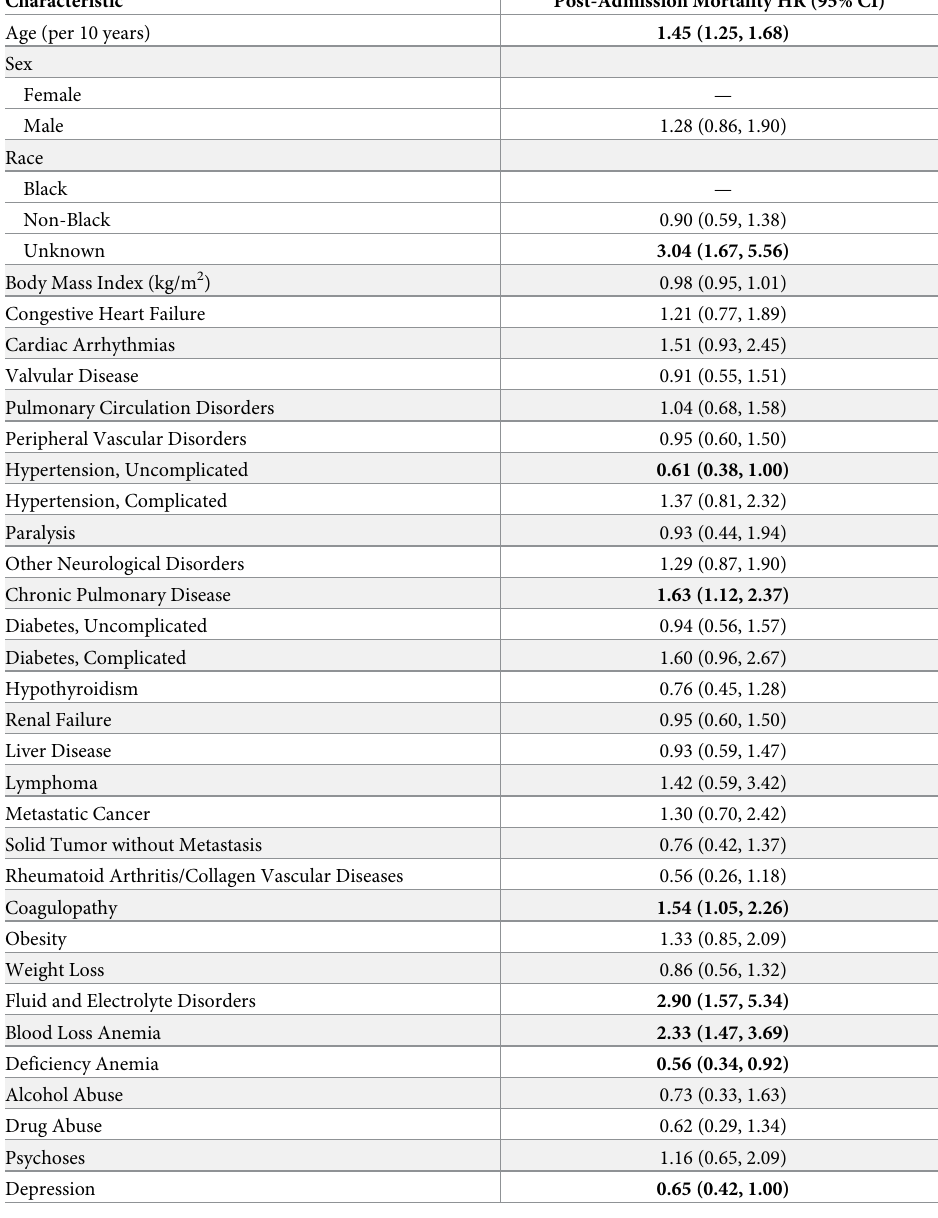
Table 4. Adjusted associations of patient demographic and clinical risk factors with COVID-19 outcomes among hospitalized COVID-19 patients, based on a Cox proportional hazards regression for time to any death post-